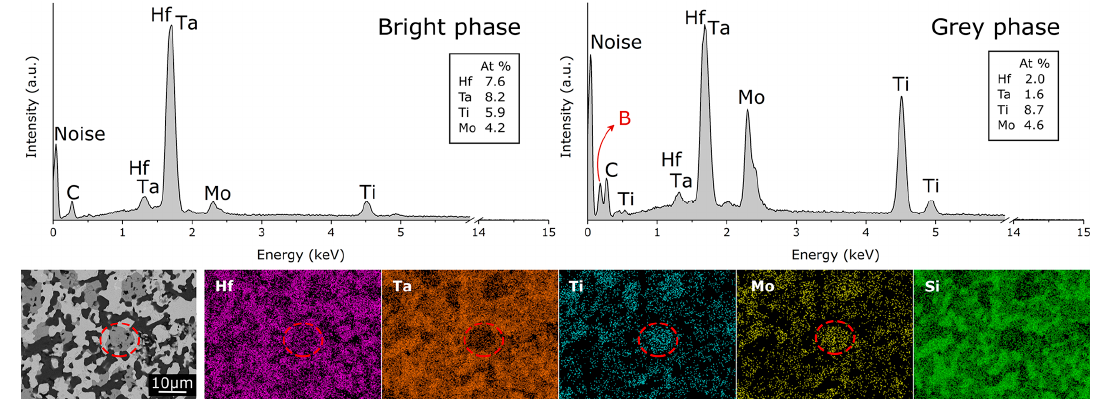
Figure 4. EDS spectra and mapping results of the bright and gray phase shown in the backscattered electron (BSE) microstructure, obtained from electron (BSE) microstructure, obtained from HEC-(SiC)1.0.